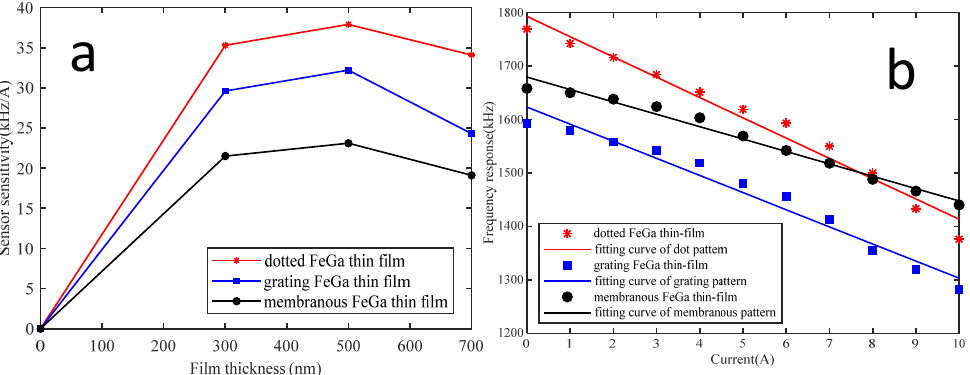
Figure 7. ( a ) The effects of film thickness on the sensor sensitivity; ( b ) the frequency response of current sensor with a 500 nm thick